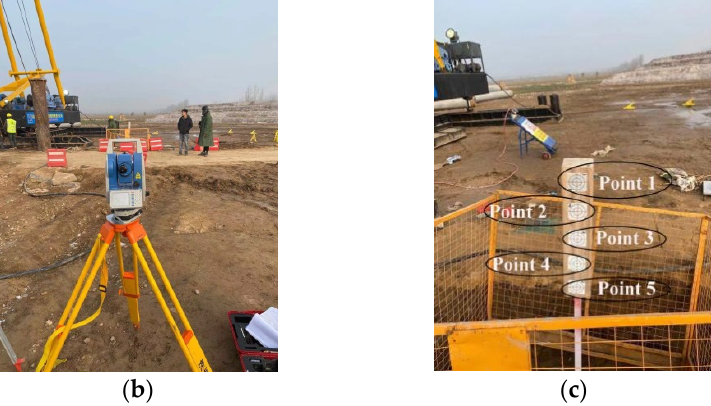
Figure 7. Site schematic diagram of large diameter pipe pile construction effect experiment, showing the ( a ) digital camera, ( b ) total station, and ( c ) self-made monitoring steel